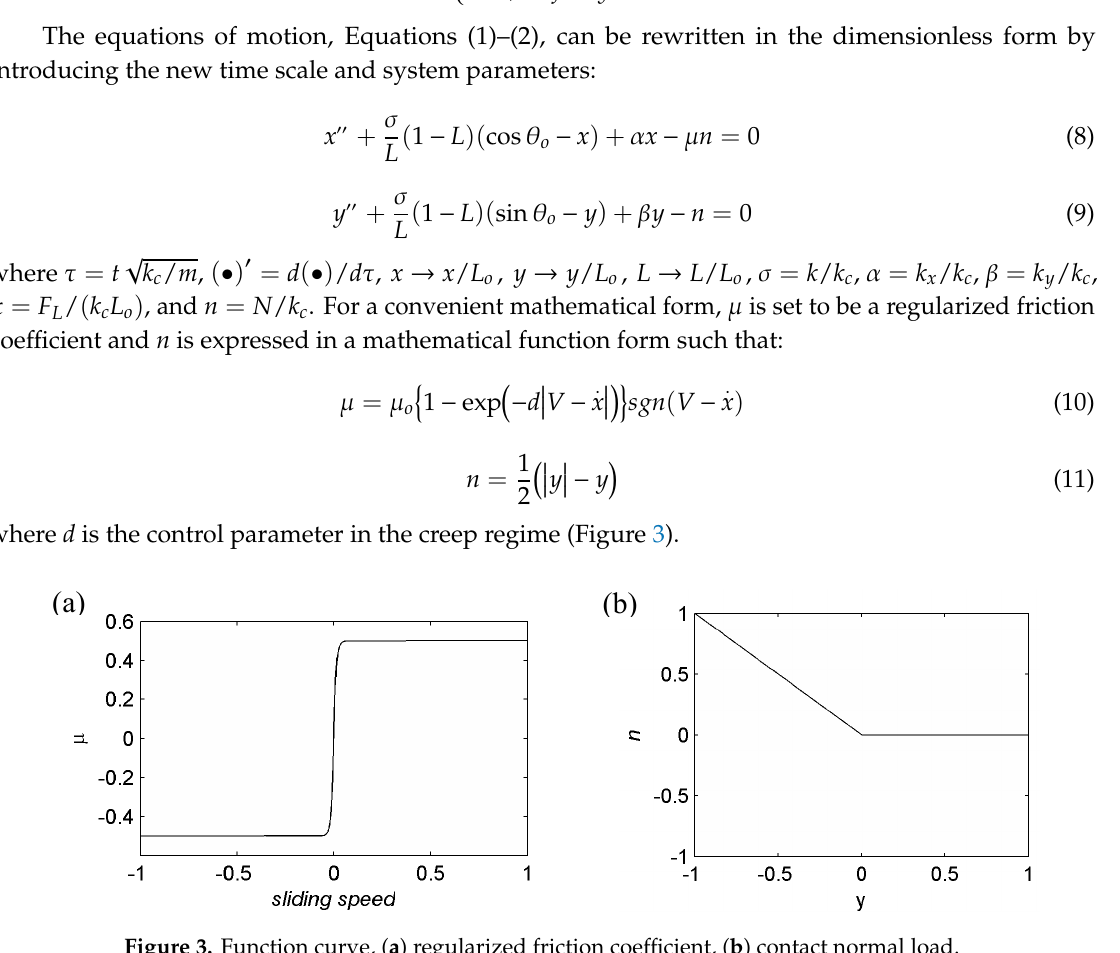
Figure 3. Function curve, ( a ) regularized friction coe ffi cient, ( b ) contact normal load.